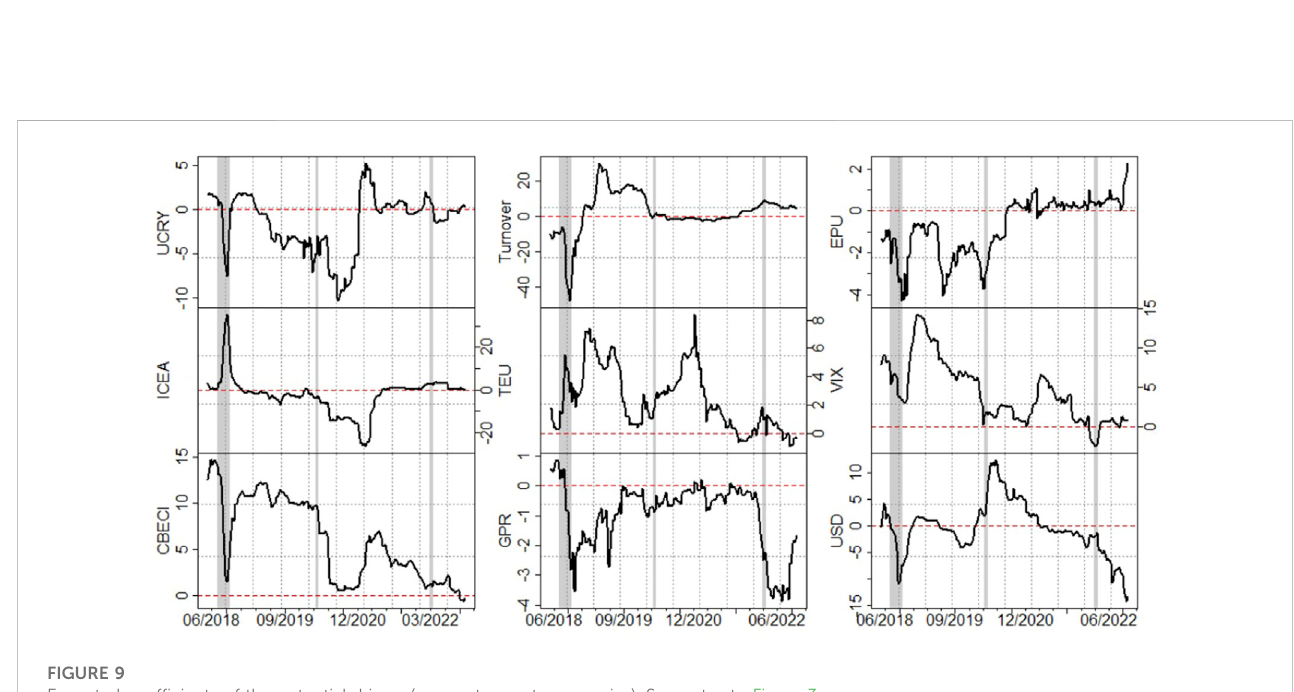
FIGURE 9 Expected coef fi cients of the potential drivers (energy to cryptocurrencies). See notes to Figure